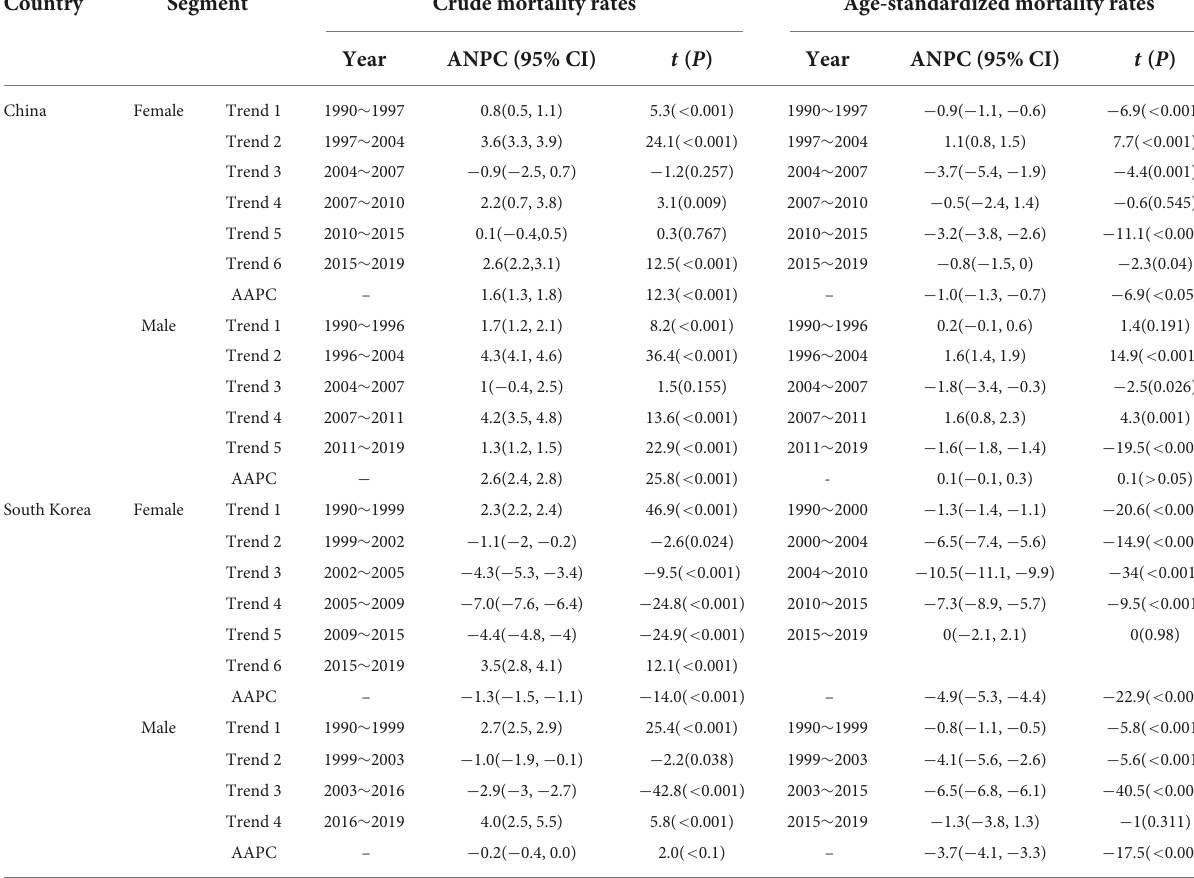
TABLE 1 Annual percent change of crude and age-standardized mortality attributable to high red meat intake by gender and country from 1990 to 2019. Country Segment Crude mortality rates Age-standardized mortality